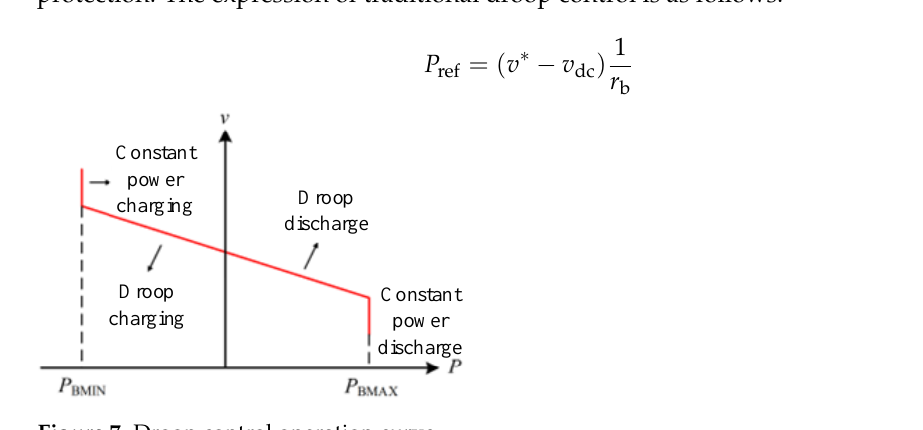
Figure 7. Droop control operation curve.